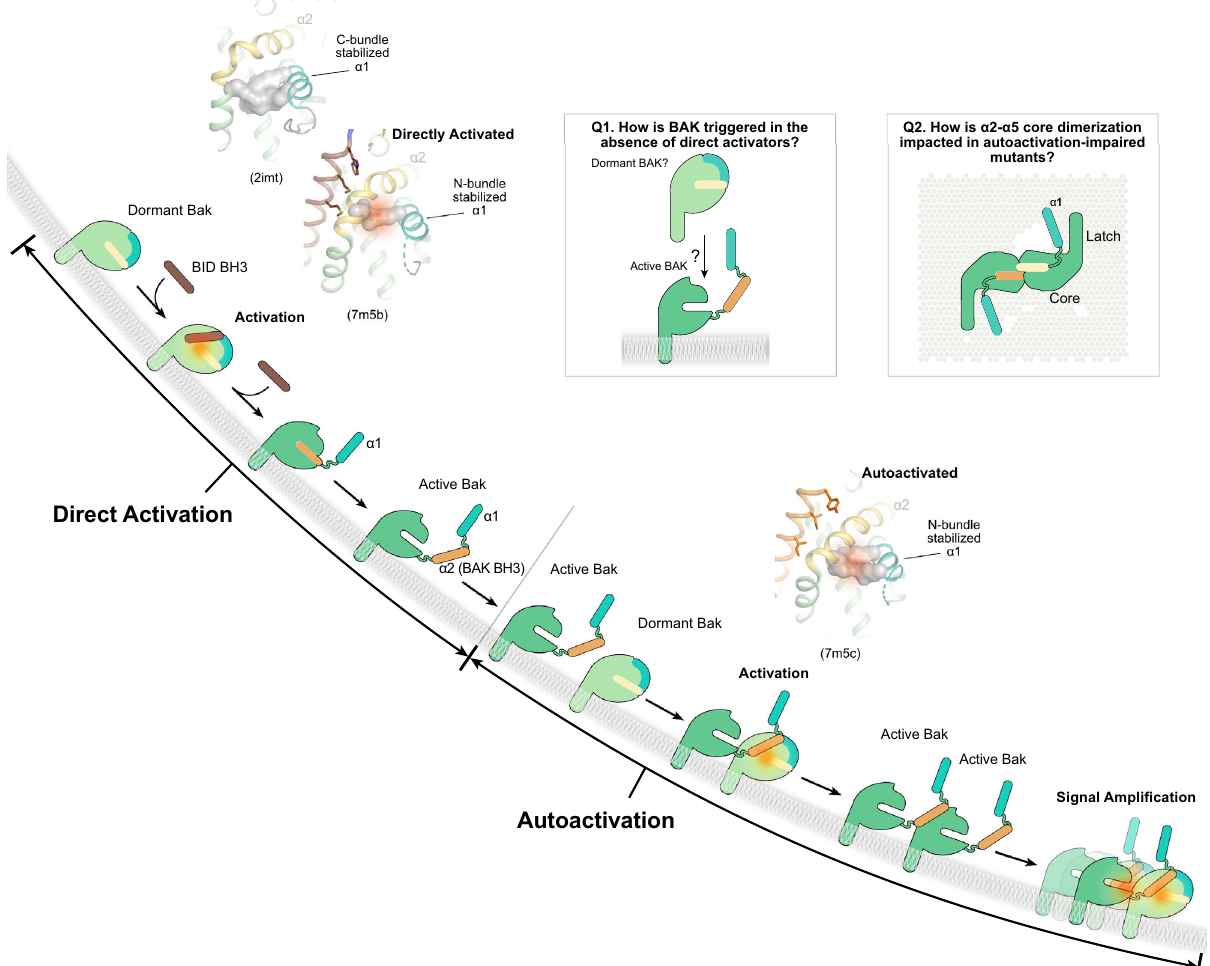
Fig. 7 Cooperation of autoactivation and direct activation in apoptosis initiation by BAK. Direct BAK activation by BH3-only proteins cooperates with BAK autoactivation in trans to lower BAK threshold and to amplify the response leading to mitochondrial poration (Supplementary Movie 2). BAK autoactivation involves binding the exposed BH3 of active BAK to the activation groove of dormant BAK. Our structural analyses of autoactivated (7m5c) and directly activated (7m5b) BAK reveal BH3 ligand-induced conformational changes in the protein core that promote helix α 1 destabilization as the mechanistic basis of BAK activation (inset cartoons). In activated BAK complexes helix α 1 electrostatic network is destabilized as it rearranges within the N-bundle (helices α 1- α 2), which dissociates in the presence of membranes but not in solution. In contrast, in dormant, apo BAK (2ims) and an inactivated BAK complex bound to a rationally-designed BID-like BH3 peptide (7m5a), helix α 1 is stabilized by the electrostatic network within the C-bundle (helices α 3- α 8), which prevents N-bundle dissociation at membranes (Supplementary Movie 1). How active BAK porates membranes is unclear but oligomerization of the BAK α 2- α 5 core dimers has been postulated. Mechanistic questions not addressed in our study are